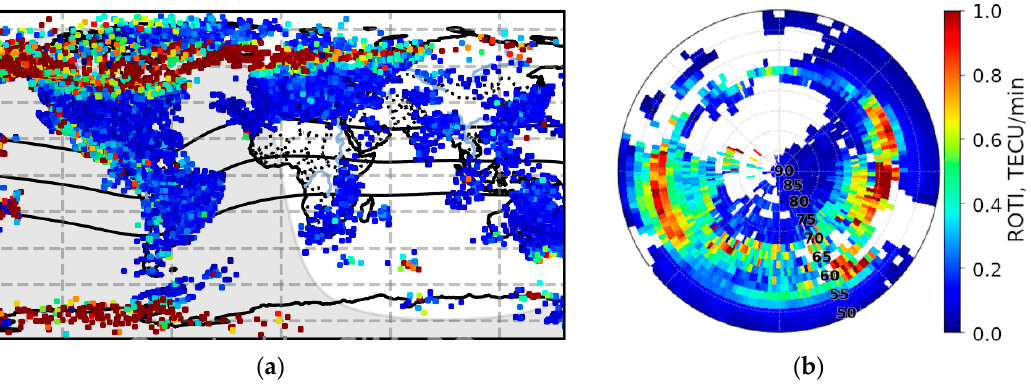
Figure 1. Dynamic ROTI maps in different frames on 26 August 2018: ( a ) 30-s map of ROTI at 06:00 UT from SIMuRG service; ( b ) map of ROTI averaged for Northern Hemisphere in MLAT × MLT reference frame over 1 h (5:30–6:30 UT).